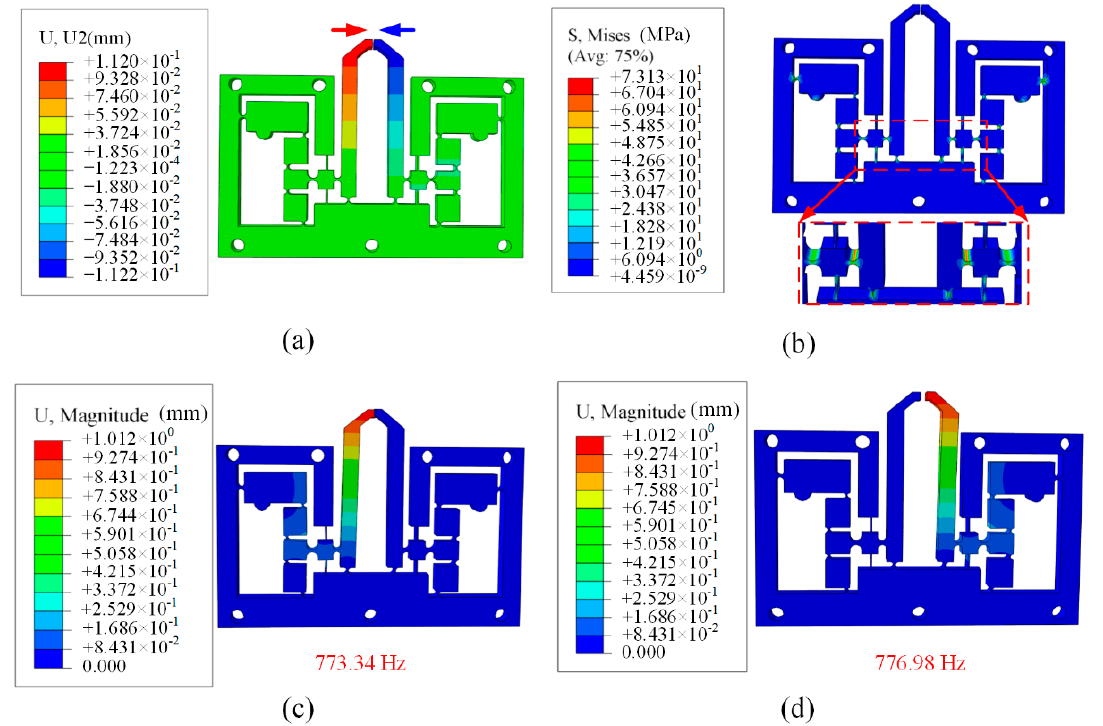
Figure 3. The FEA results of ( a ) the deformation behavior, ( b ) stress distribution, ( c ) the first modal shapes and ( d ) the second modal shapes.